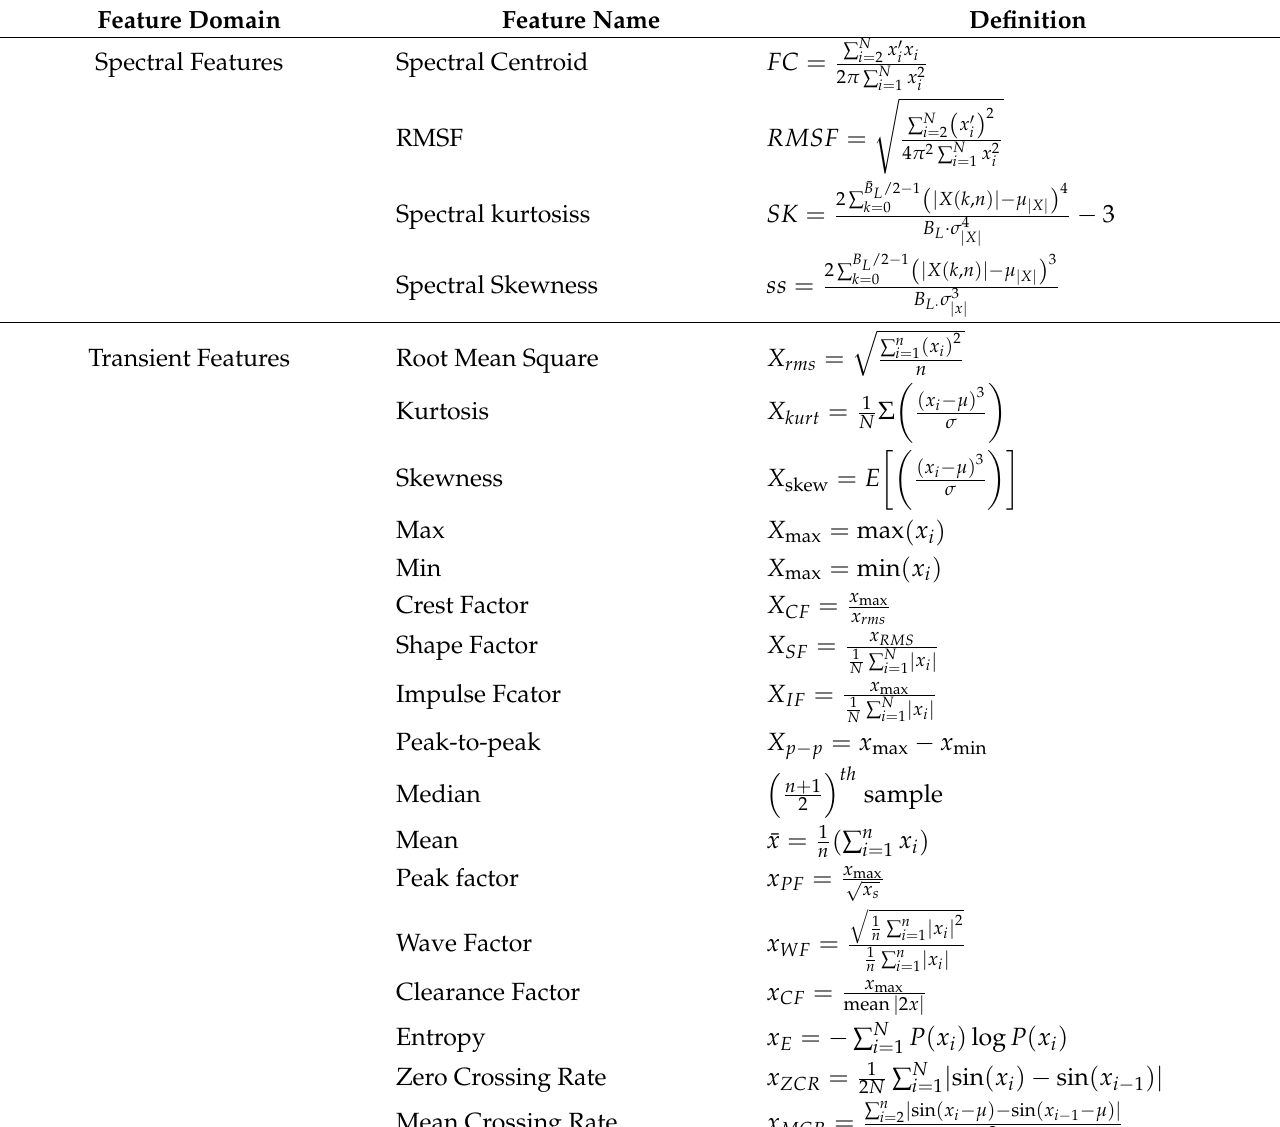
Table 3. Extracted features and their